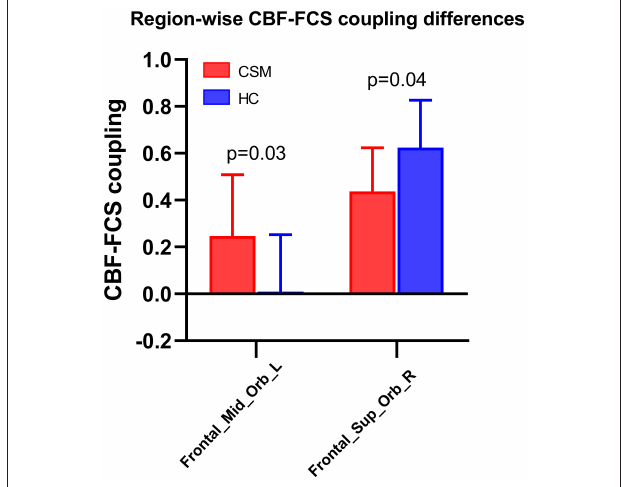
FIGURE 2 | Region-wise CBF–FCS coupling changes based on anatomical automatic labeling (AAL) in cervical spondylotic myelopathy (CSM) patients. Significant CBF-FCS correlation across voxels within the middle frontal gyrus and superior frontal gyrus were observed between CSM patients and healthy individuals. Error bars represent the SD. FDR-corrected p -values are shown above the bars. CBF, cerebral blood flow; FCS, functional connectivity strength.